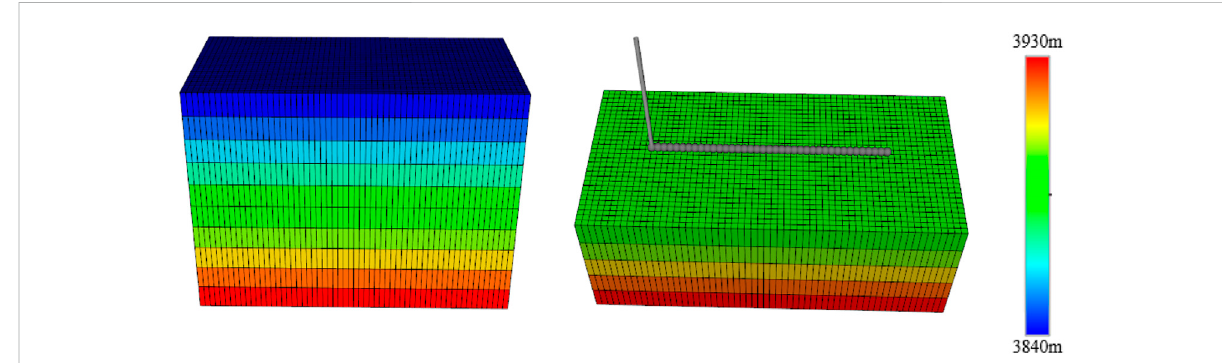
FIGURE 4 Schematic diagram of the burial depth and well location in the research area of well W in the H oil reservoir of the Liaohe oil fi eld.